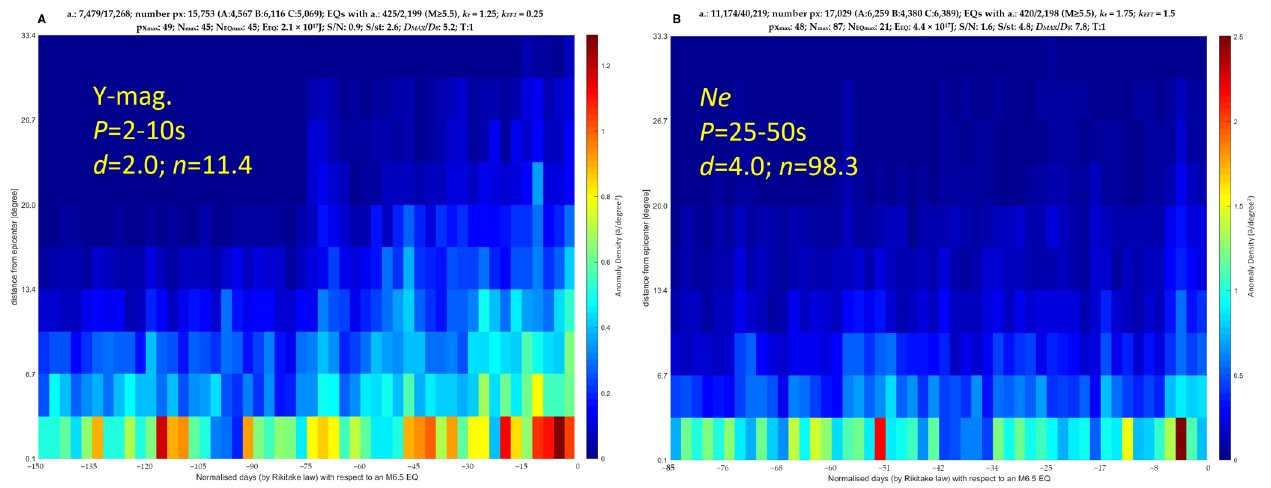
Figure 8. Swarm magnetic field data in the shorter period of 2–10 s (Y-mag in ( A )) and electron density in the longer period of 25–50 s ( Ne in ( B )) correlated with M5.5+ earthquakes using modified time according to the empirical Rikitake law.